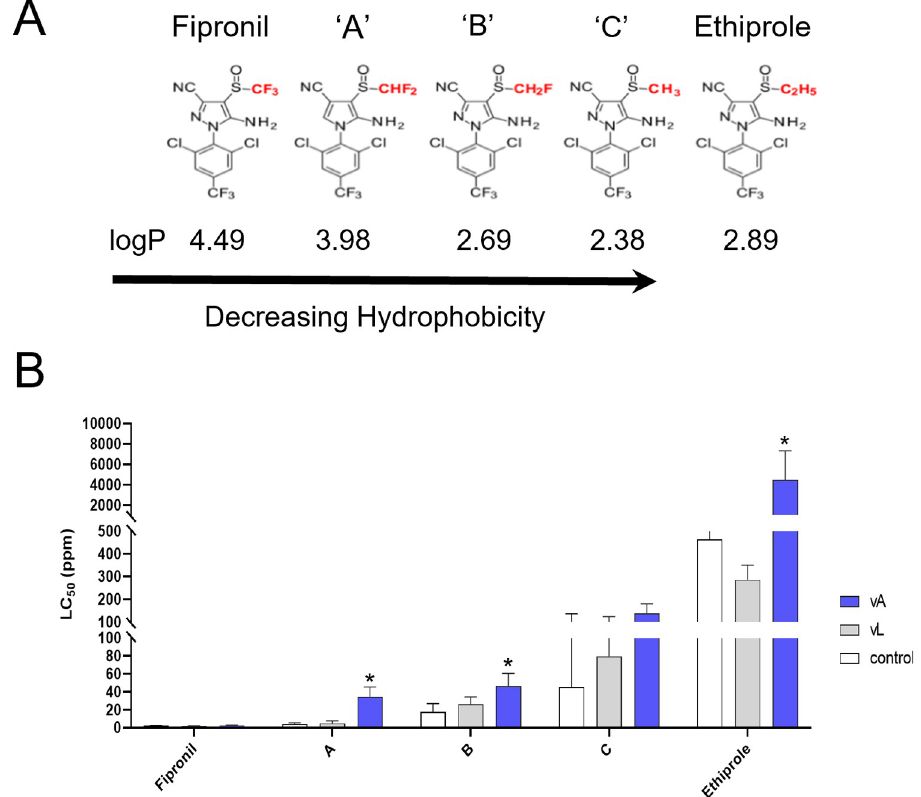
Fig 7. Substrate lipophilicity and relationship to insecticidal efficacy. A) Atoms that are substituted in the chemical structures of fipronil, ethiprole and compounds of intermediate halogenation are coloured red. B) Lethal Concentration 50% (LC 50 ) values derived from full dose-response bioassays are displayed for D . melanogaster strains expressing CYP6ER1vA, CYP6ER1vL or no transgene for the compounds fipronil, ethiprole and their intermediates. Error bars show 95% CI (n = 4). Significant differences (p = < 0.05) in LC 50 values of fly lines expressing CYP6ER1vA and the no transgene control, identified by z- tests using the compParm() function of the ’drc’ package [36], are indicated using an asterisk above relevant bars. See also S8